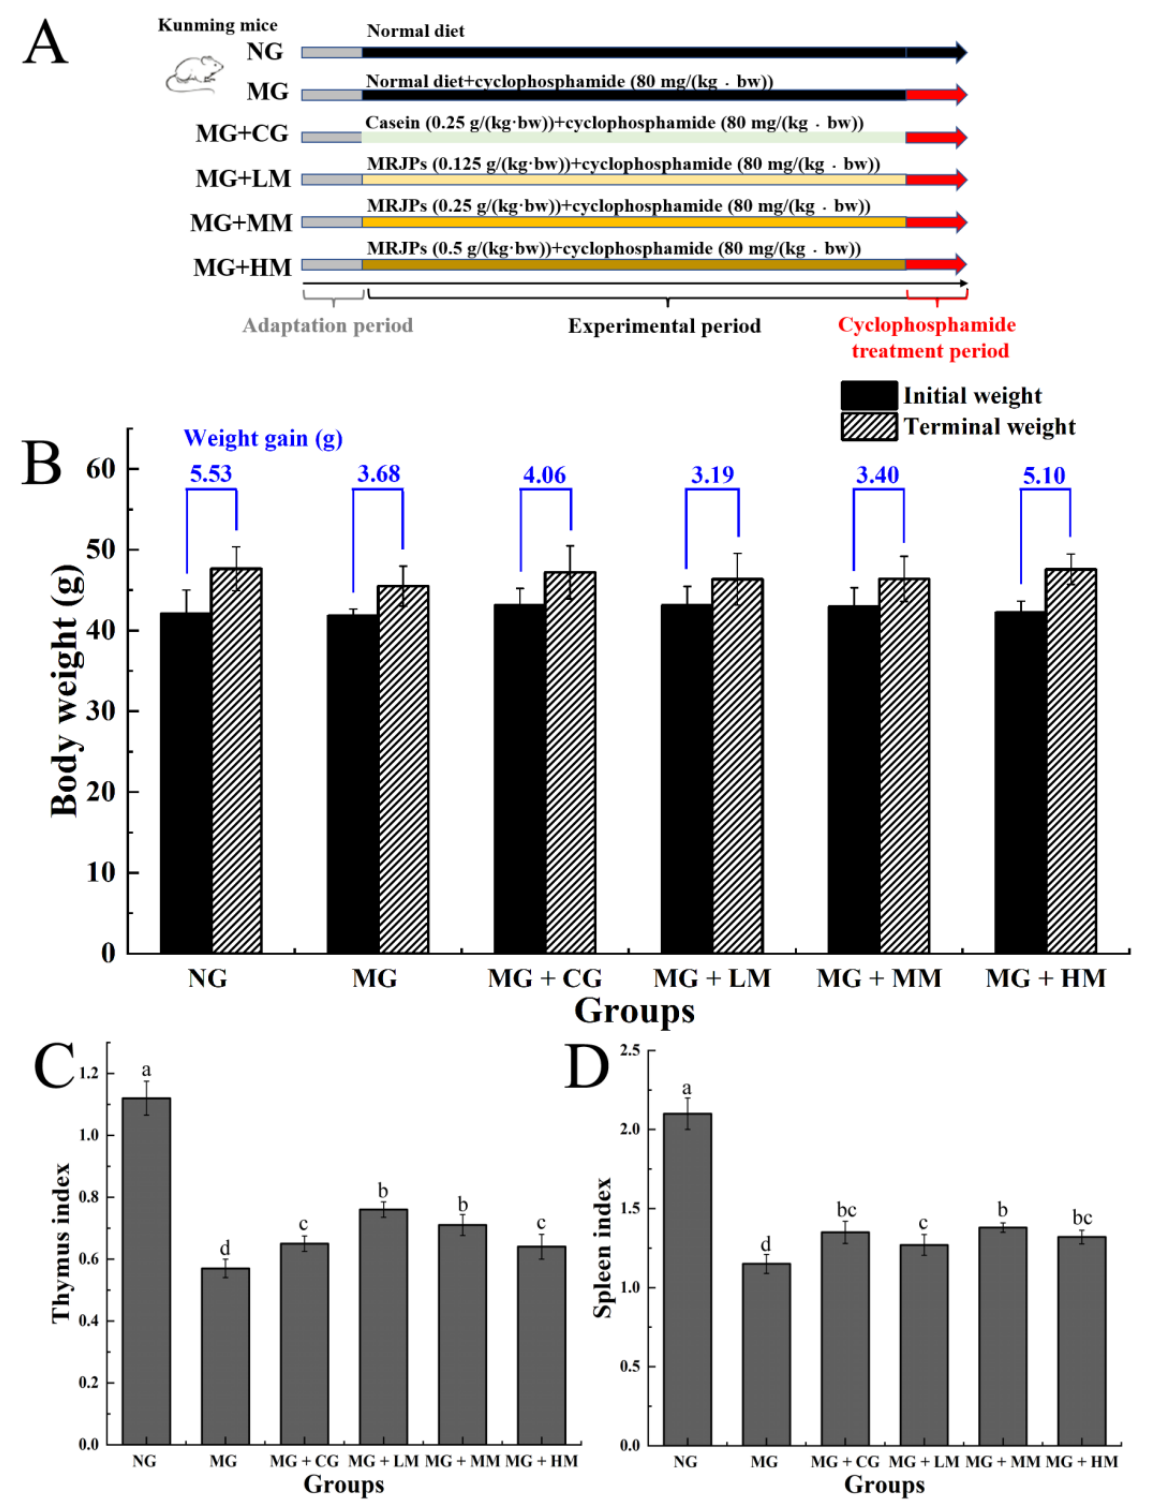
Figure 3. Experiment design and influences of MRJPs on the body weight and organ index of cyclophosphamide-induced, immunodeficient mice. ( A ) Animal experimental design; ( B ) influences of MRJPs on body weight of cyclophosphamide-induced, immunodeficient mice; ( C ) influences of MRJPs on thymus index of cyclophosphamide-induced, immunodeficient mice; and ( D ) effects of MRJPs on spleen index of cyclophosphamide-induced, immunodeficient mice. The different letters above each bar indicate statistically significant differences ( p < 0.05).